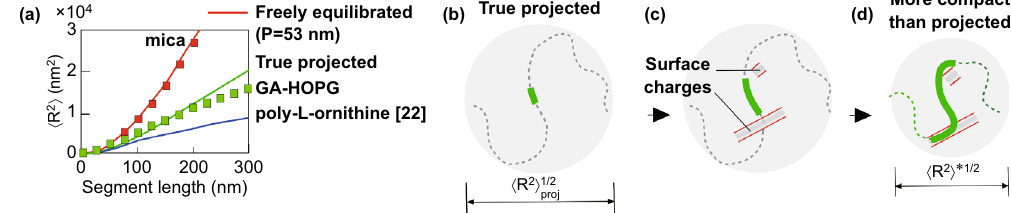
Fig. 4 The impact of the low‑scale bending on the large‑scale DNA behavior. a Experimental dependences 〈 R 2 (L) 〉 of the mean‑square end‑ to‑end distance as a function of the segment length for DNA adsorbed on mica and GA/HOPG (red and green curves taken from Fig. 1k of the present study) and for poly‑L‑ornithine film on mica (blue curve taken from Fig. 4 of Ref. [22]). b–d A schematic of the bending‑induced two‑ dimensional compactification of the DNA surface conformations below the limit of the “true projected” conformations in the course of adsorp‑ tion. The DNA adsorption starts from a site shown by green in (b). Of multiple involved bending acts, only two are shown in (c). The effective persistence length of the conformation (c) derived from the measurements of the end‑to‑end distances is